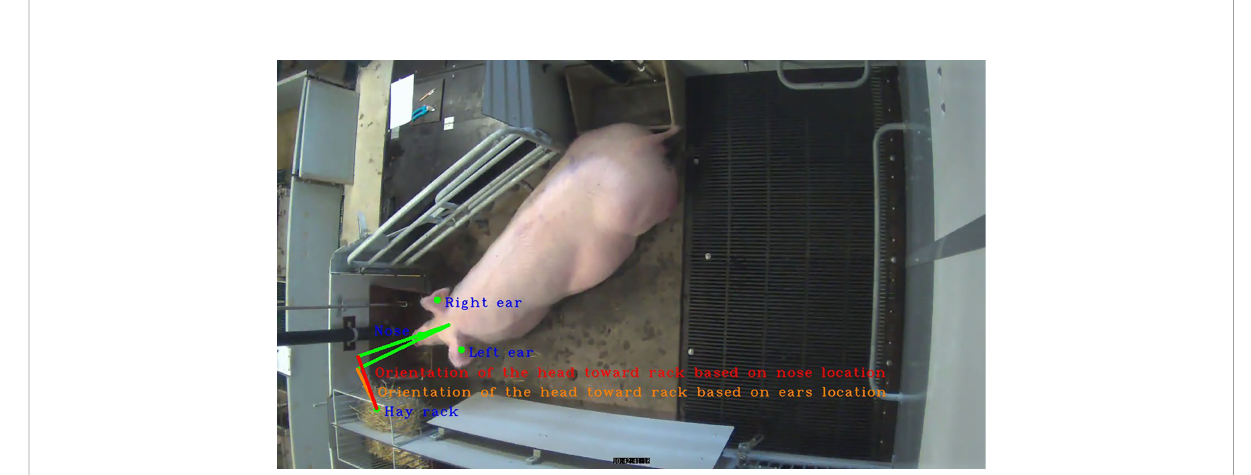
FIGURE 4 Orientation of the head toward the rack based on the location of the nose and